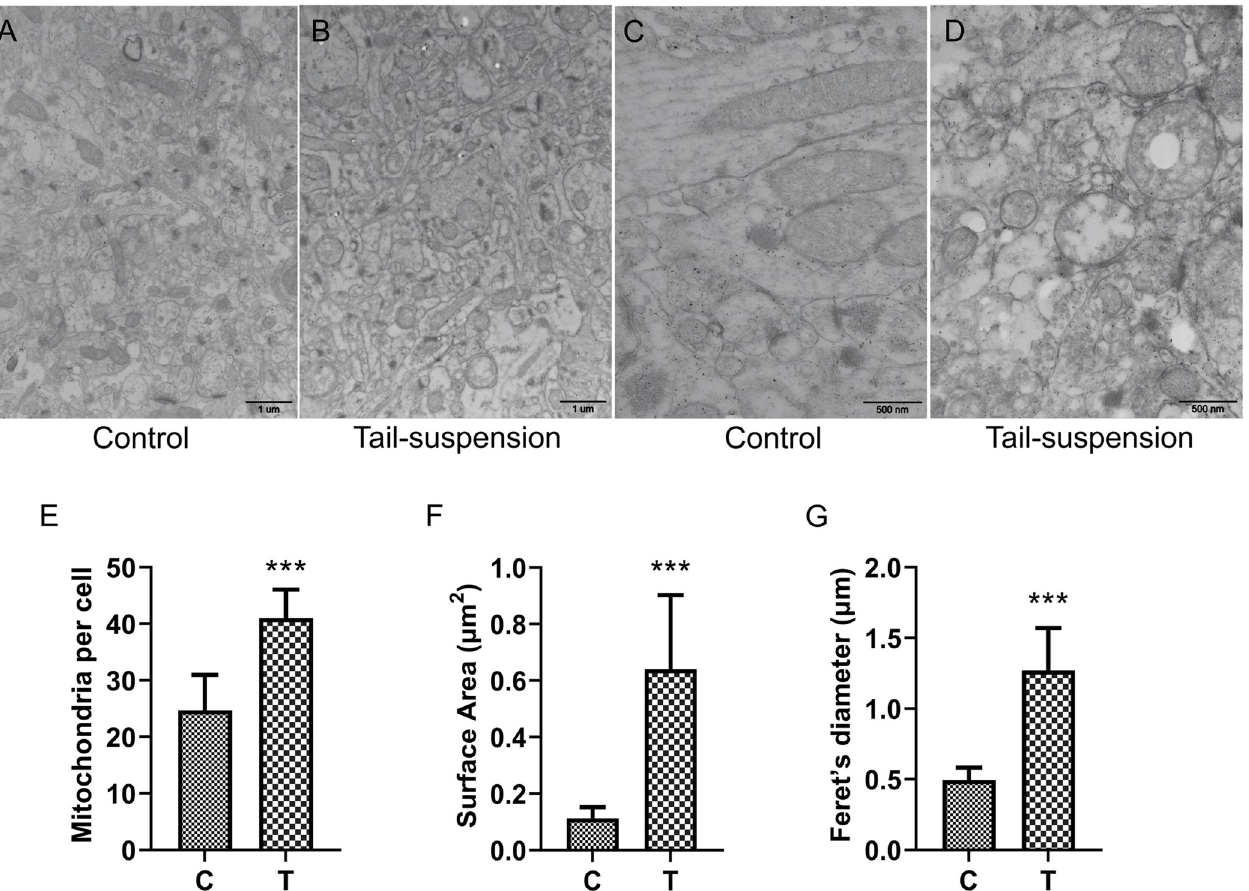
Fig 1. Effects of SM on mitochondrial morphology and dynamics of hippocampal neuronal soma in rats. Rats were tail suspended for 28 days, and the mitochondria in hippocampal neuronal soma were observed under transmission electron microscope. (A, B) Zoom 20,000 times. n = 6. (C, D) Zoom 50,000 times. (E) Mitochondria per cell were counted. n � 10 images per group. (F, G) mitochondrial mean surface area and Feret’s diameter on transmission electron microscopy images. n = 25. C and T represented the Control group and SM group samples respectively. ��� p < 0.001.